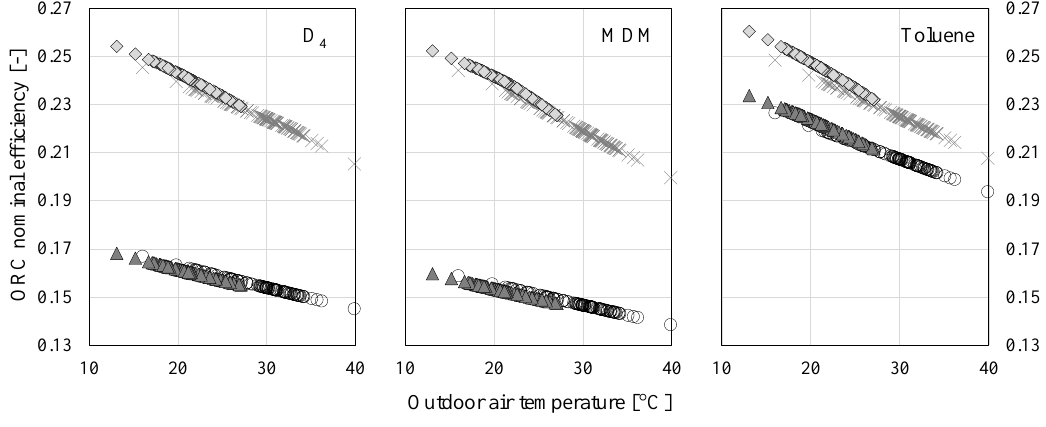
Figure 8. ORC nominal efficiency as a function of nominal outdoor air dry-bulb temperature (air-cooled condenser) or wet-bulb temperature (water-cooled